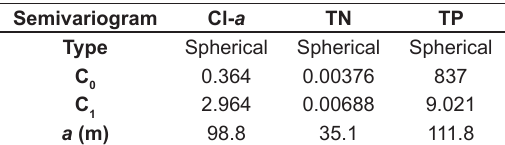
Table 2. Variographic parameters of chlorophyll- a (Cl- a ), total nitrogen (TN) and total phosphorus